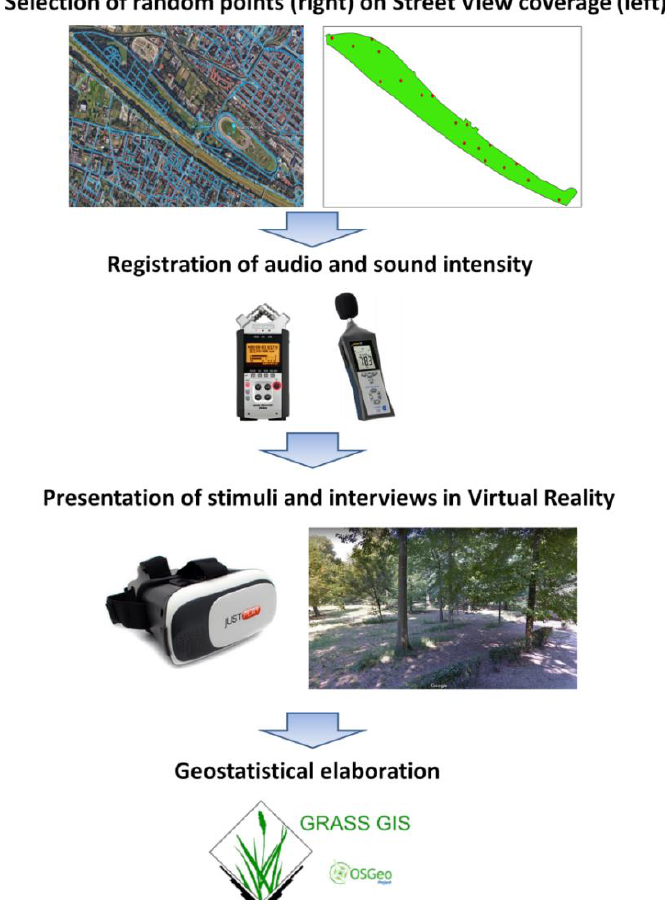
Figure 2. General framework of the study. Source: Own elaboration.